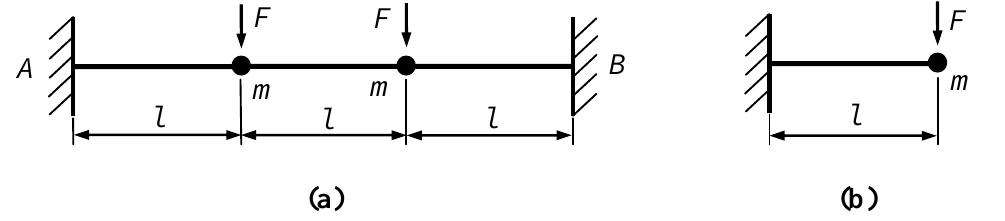
Figure 5. Kinematic analysis of the drive mode: flexural vibration of the slanted beam. (a) clamped-clamped (b)